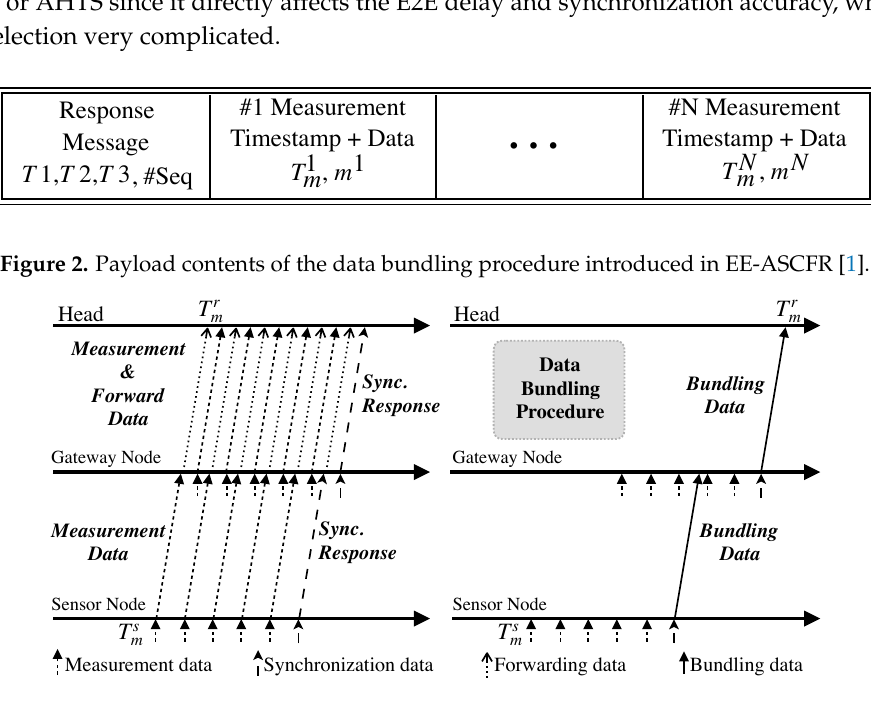
Figure 3. Comparison of the message transmissions of the time synchronization schemes with and without data bundling